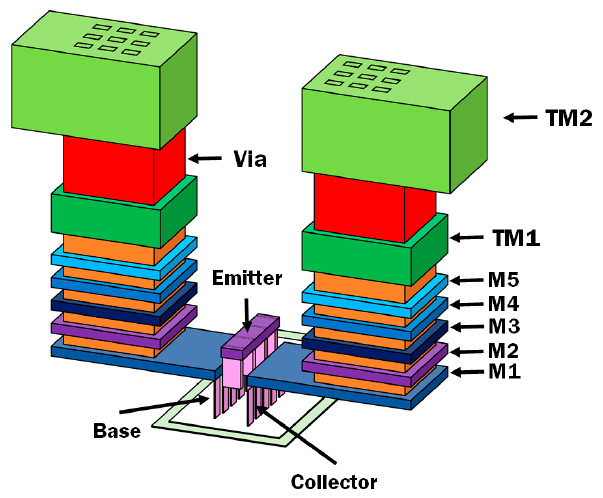
Figure 2. The connection between the active device and the passive device.